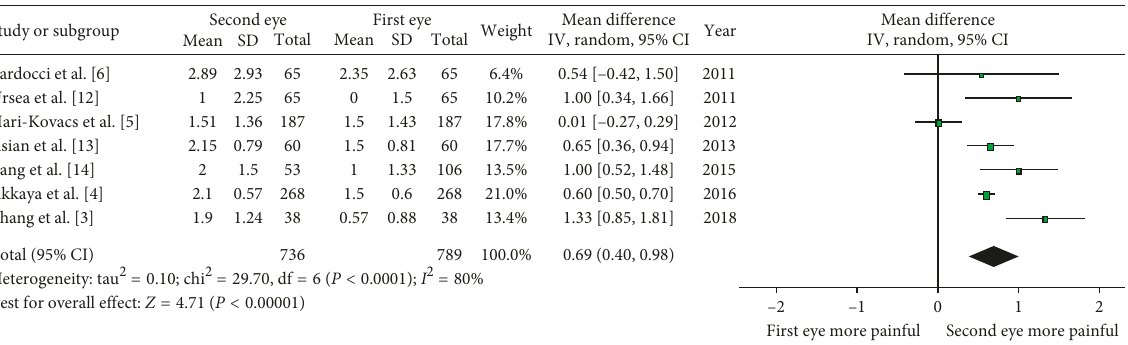
Figure 2: Forest plot comparing the pain scores shortly after the surgery.